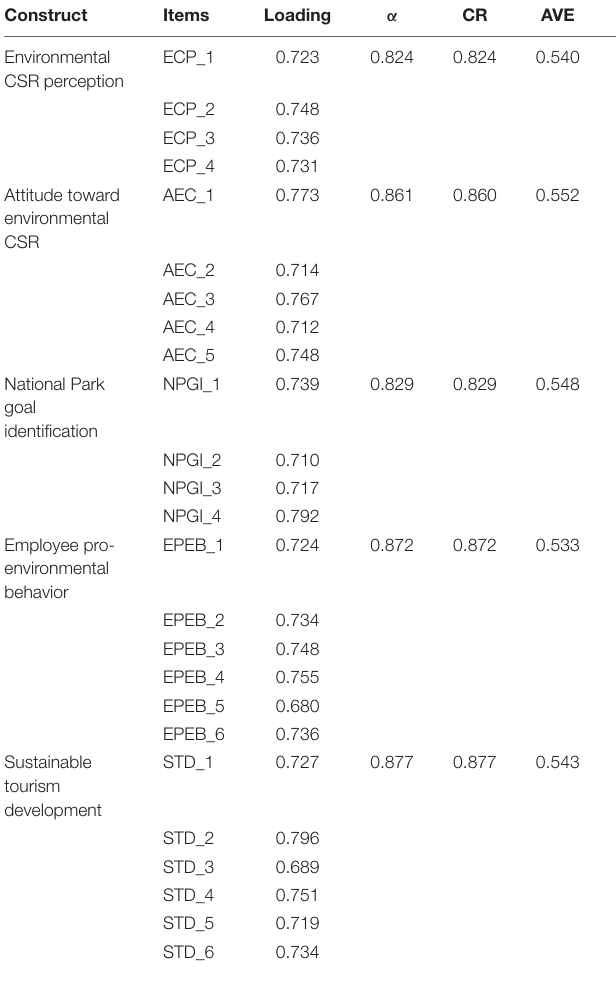
TABLE 2 | Reliability and validity analysis.